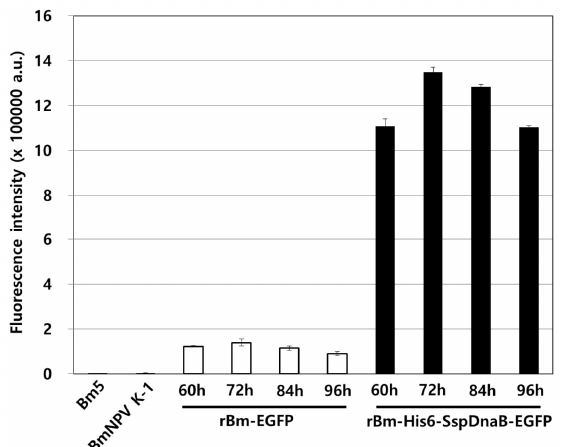
Figure 3. Fluorescence intensity of recombinant EGFP. Bm5 cells were infected with 5 MOI of each virus and harvested from 60 to 96 h.p.i at intervals of 12 h. The fluorescence intensity of the cell extracts was measured using a fluorescence spectrometer with an excitation filter of 450 nm and emission filter of 510 nm. The bars indicate the mean ± SE ( n = 3).